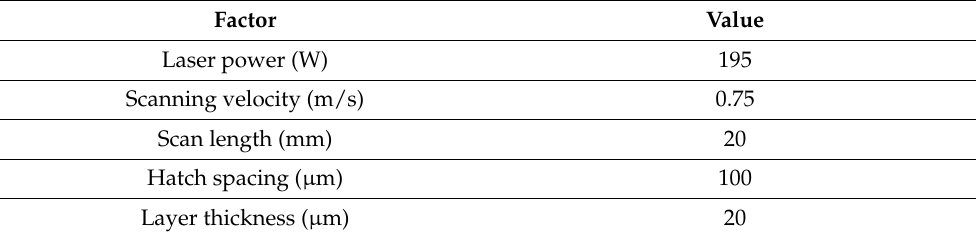
Table 4. Levels of the processing parameters in LPBF in full melting mode.